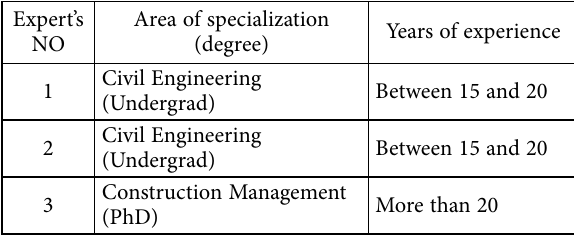
Table 3. Experts’ profile